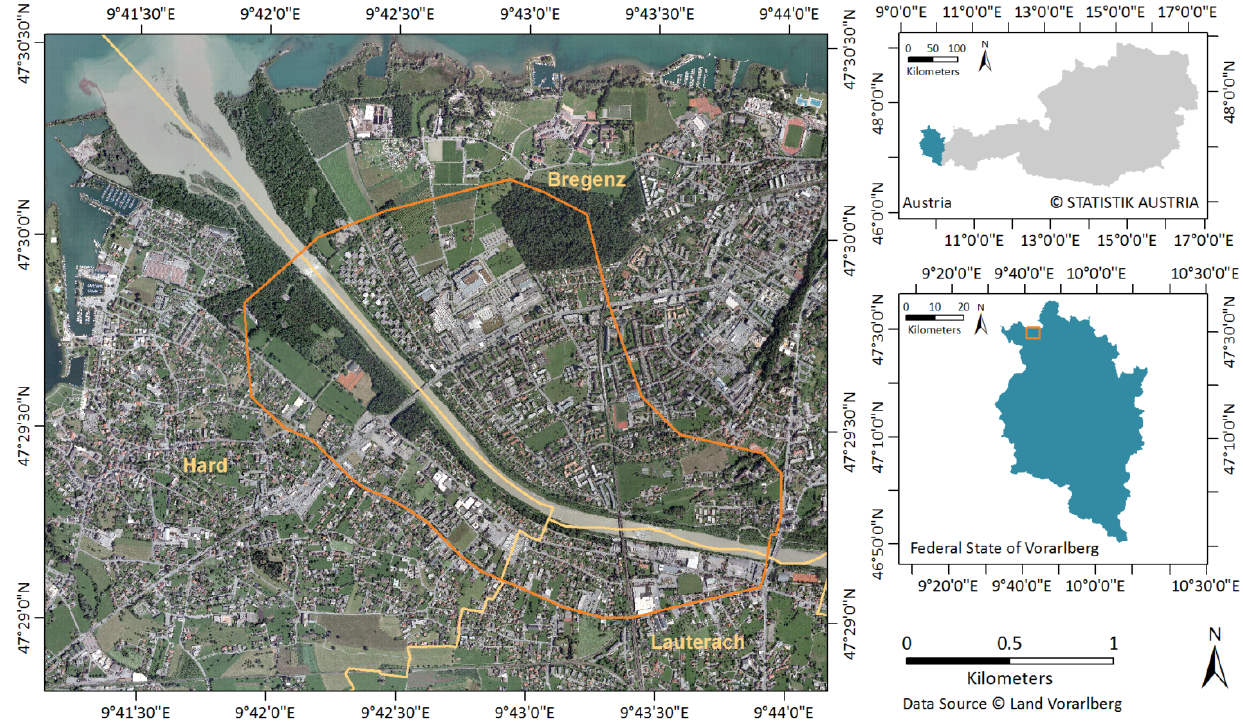
Figure 1. Location of the study site in the Austrian Alps at the Lake